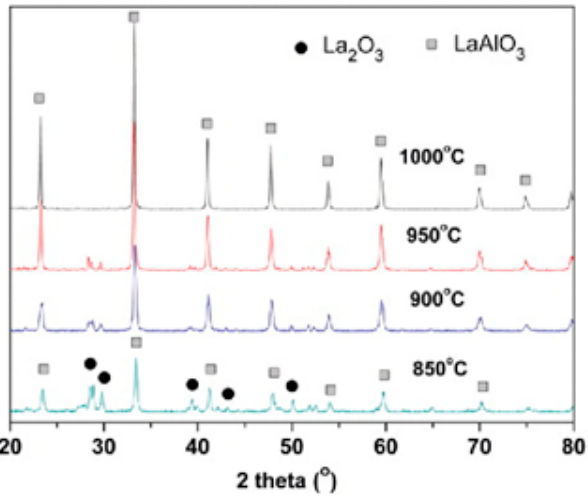
Figure 11. XRD patterns of LaAlO 3 perovskites obtained by molten salt synthesis in the range of 850–1000 °C for 3 h. (Adapted from [54]). 850–1000 ◦ C for 3 h. (Adapted from